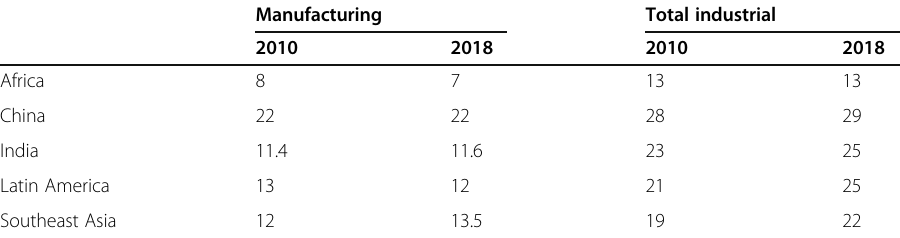
Table 3 Stalled industrialization: manufacturing and industrial employment in the Global South, 2010 – 2018 (percent of total